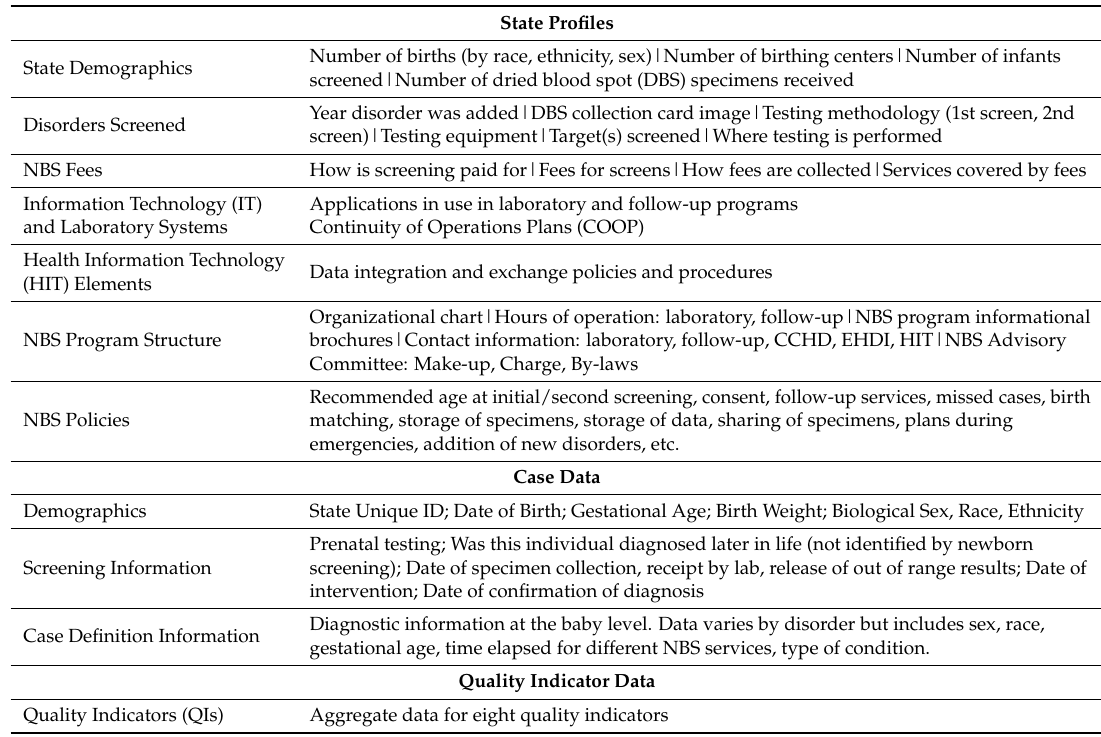
Table 4. Data Elements Collected Within the NewSTEPs Data